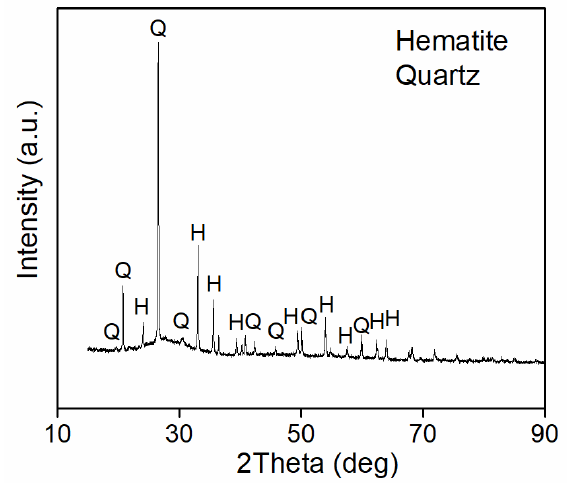
Figure A13. XRD result from the grisaille where hematite PA was used. Hematite (H) was identified.